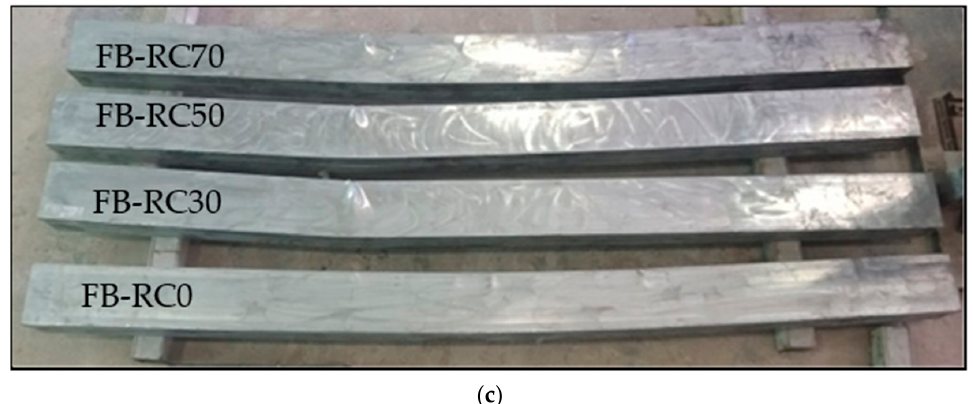
Figure 3. Typical failure modes: ( a ) unfilled specimen (HB); ( b ) filled specimen (FB-RC30); ( c ) all filled specimens after testing.